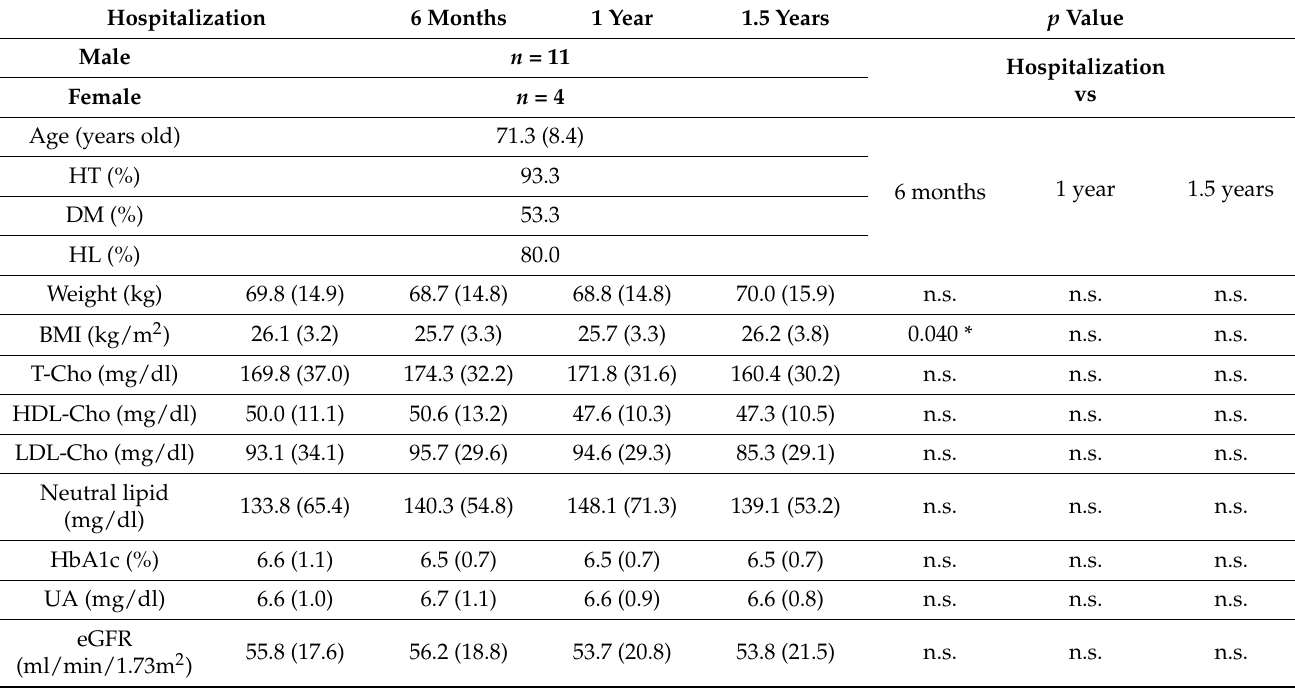
Table 1. Changes in anthropometry and blood biochemical examination ( n =